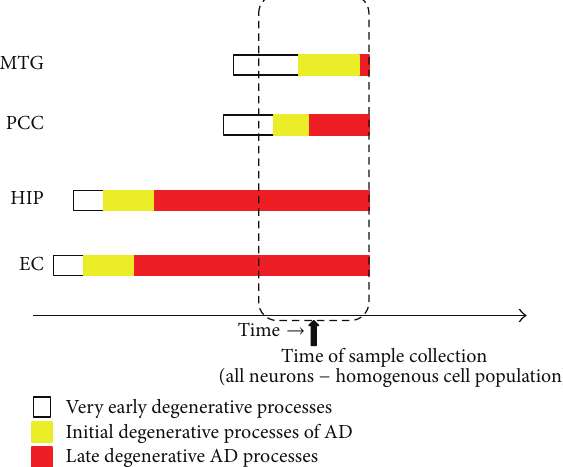
Figure 1: Sample collection and degenerative processes. This figure shows how different brain regions (EC: entorhinal cortex; HIP: hippocampus; PCC: posterior cingulate cortex; MTG: middle tem- poral gyrus) get affected with degenerative processes over time. The figure is not drawn to scale. Exactly when each set of degenerative processes (as indicated by the white, yellow, and red colors) begins in the different brain regions and how long they last in each region is unknown. This figure shows the logic used in this analysis—that when tissue is collected at the time shown, the PCC and MTG regions which get affected much later in Alzheimer’s will have initial or very early degenerative processes as compared to the HIP and EC. The late stage processes will slowly dominate the brain region and, therefore, it will be difficult to identify early AD processes with statistical significance in the EC and